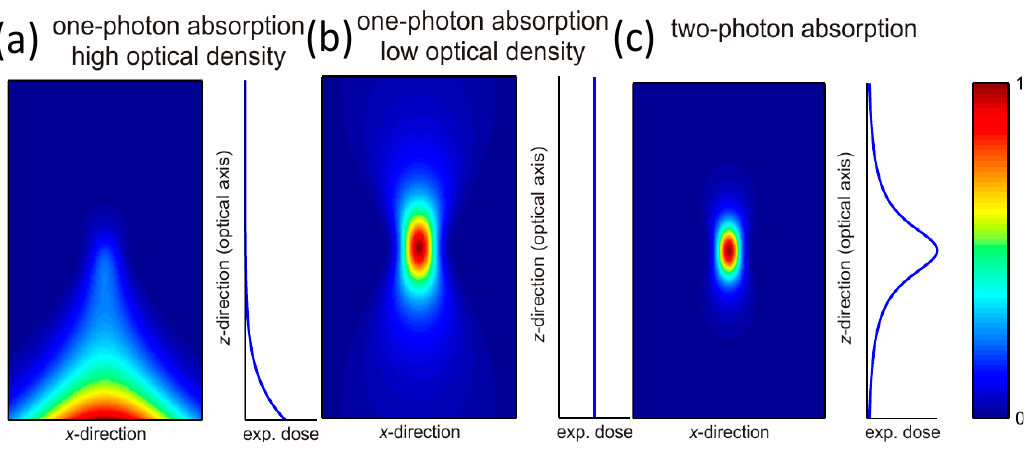
Figure 1. Illustration of laser intensity profile for ( a ) resist with high-concentration photoinitiator; ( b ) resist with low-concentration photoinitiator; ( c ) two-photon absorption profile [44].